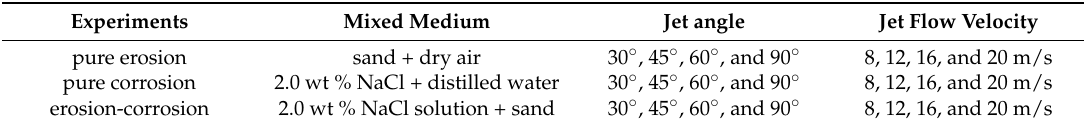
Table 3. Erosion and corrosion conditions for jet